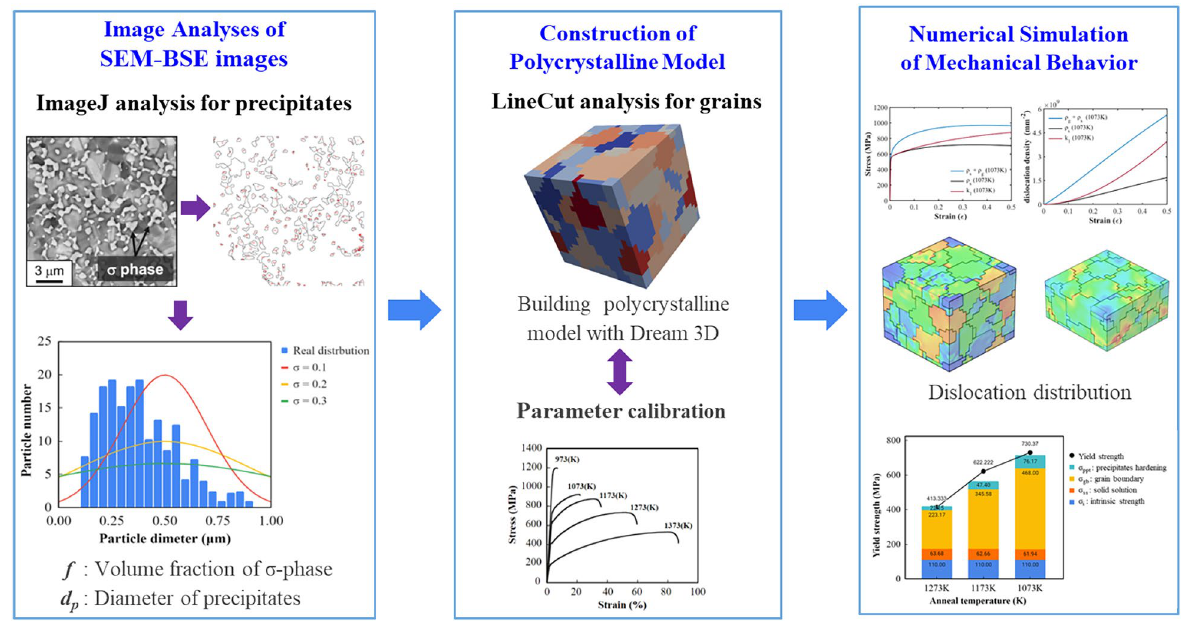
Figure 1. Analysis procedure for the study of the strengthening mechanisms of the Cr-rich CoCrFeMnNi alloy using dislocation density-based CPFEM.